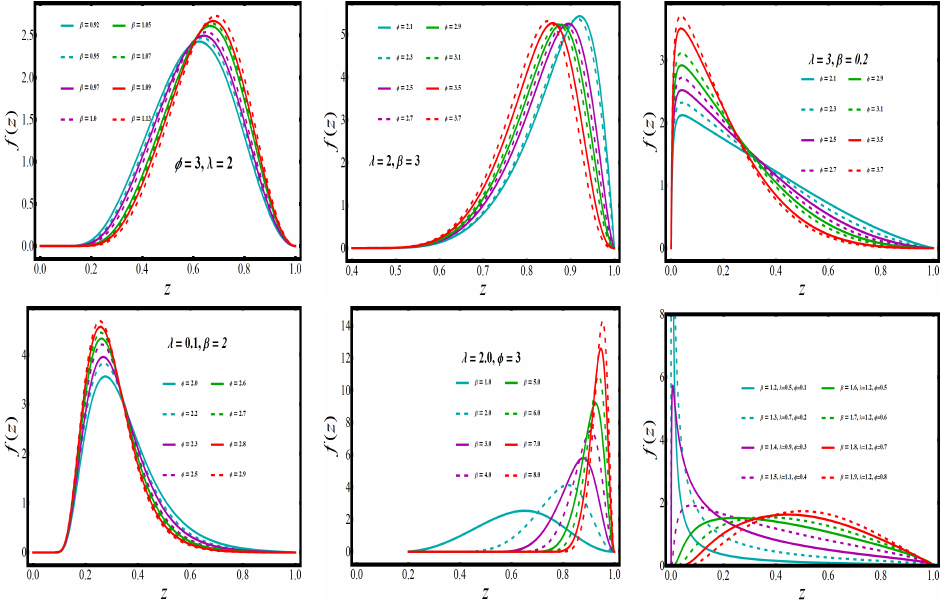
Figure 1. Variations of PDF of the HLUG-TI for different parameter Fig. 1. Variations of PDF of the HLUG-TI for di⁄erent parameter values.